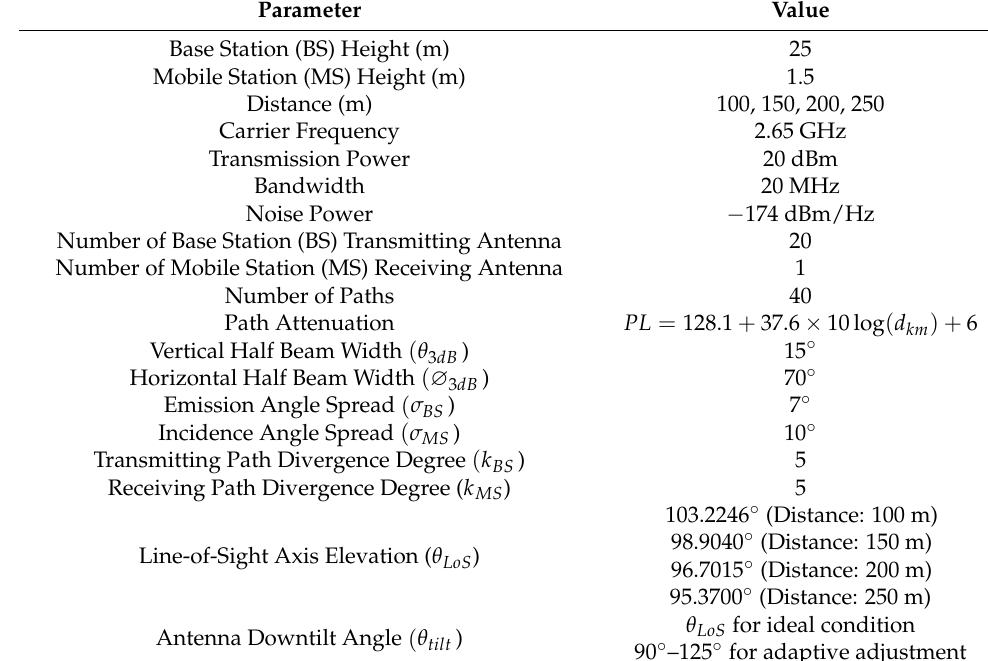
Table 2. Simulation parameters for 20 × 1.